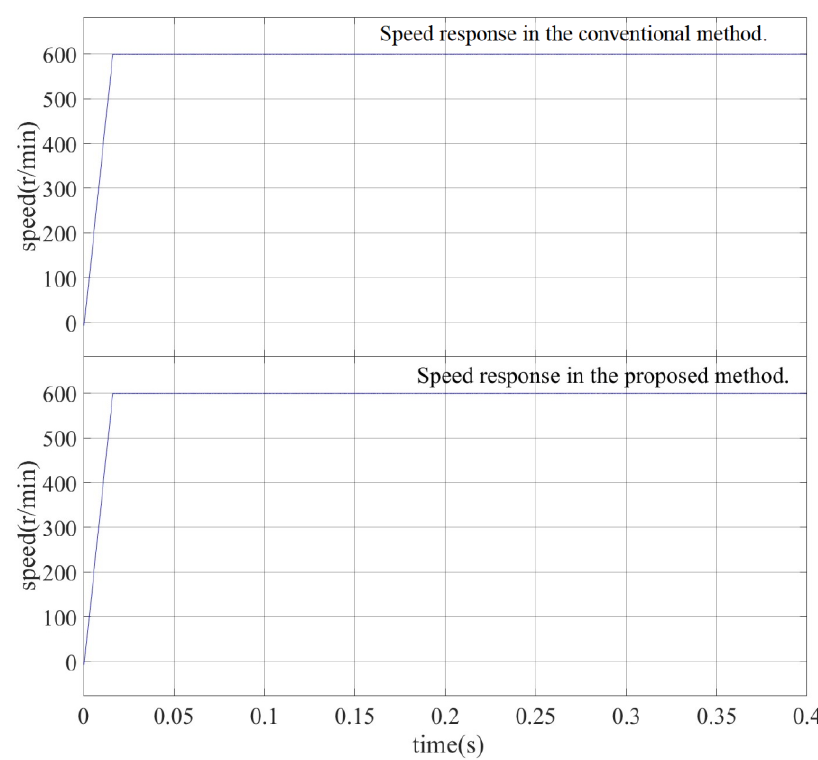
Figure 14. Speed response when the motor is under load.